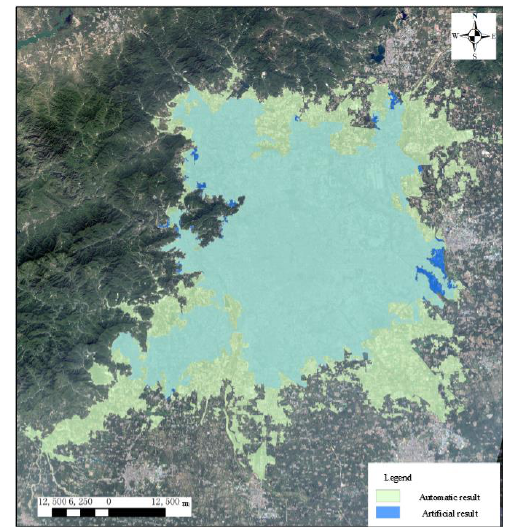
Figure 6. Automatic extraction result and artificial